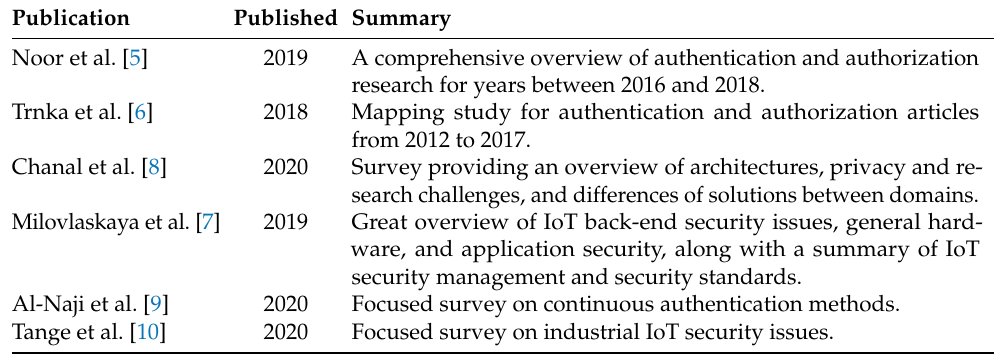
Table 1. Overview of related